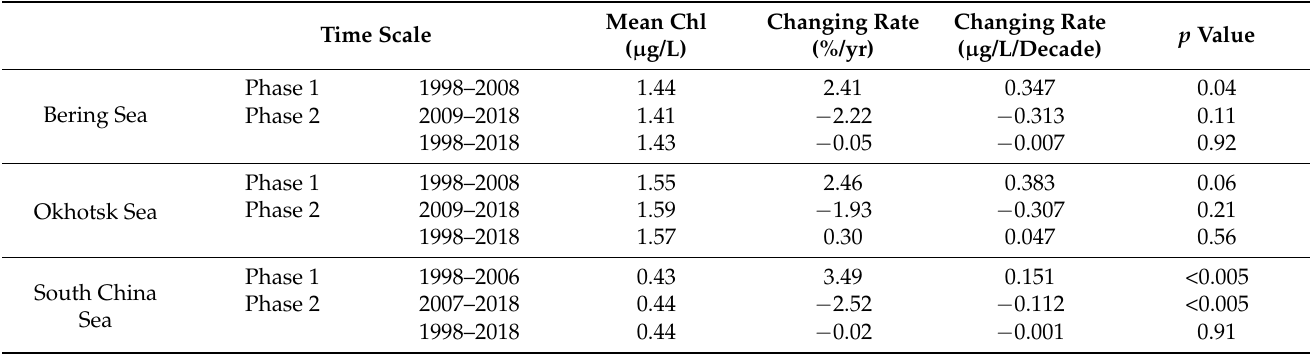
Table 2. Changing rate and statistical information of Chl during different